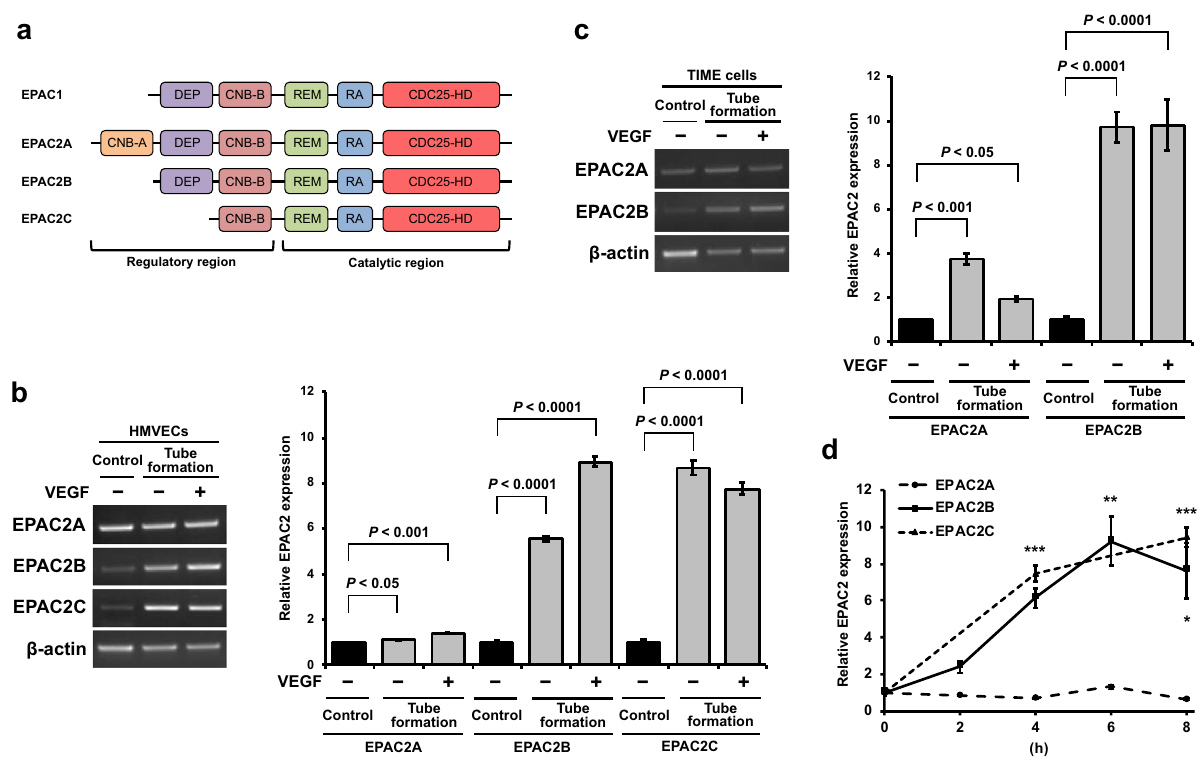
Figure 3. EPAC2 isoform expression in endothelial cells in the in vitro tube formation. ( a ) Schematic representation of EPAC1 and EPAC2 isoforms. EPAC1 and EPAC2 have an N-terminal regulatory region and a C-terminal catalytic region. The regulatory region comprises one or two cyclic nucleotide binding domains (CNB) and a DEP (Disheveled, Egl-10, and Pleckstrin) domain. The catalytic region contains a Ras exchange motif (REM), a Ras association (RA) domain, and a CDC25 homology domain (CDC25-HD). EPAC2A has two CNBs, but EPAC1, EPAC2B, and EPAC2C only have a CNB. ( b,c ) RT-PCR analysis of EPAC2 isoforms using isoform-specific primers. HMVECs ( b ) and TIME cells ( c ) were cultured on Matrigel in the presence or absence of VEGF for 8 h, and RT-PCR was performed using variant-specific primers. Band intensity was quantified, and data were expressed as mean ± S.E.M. (n = 3). ( d ) Time-course experiment of the EPAC2 isoform expression. HMVECs were cultured on Matrigel in the presence of VEGF, and total RNAs were prepared at the indicated time. Band intensity was quantified and data were expressed as mean ± S.E.M. (n = 3). * P < 0.05, ** P < 0.01, and *** P < 0.001 versus 0 h. Full-length gels are presented in Supplementary Fig. S4.